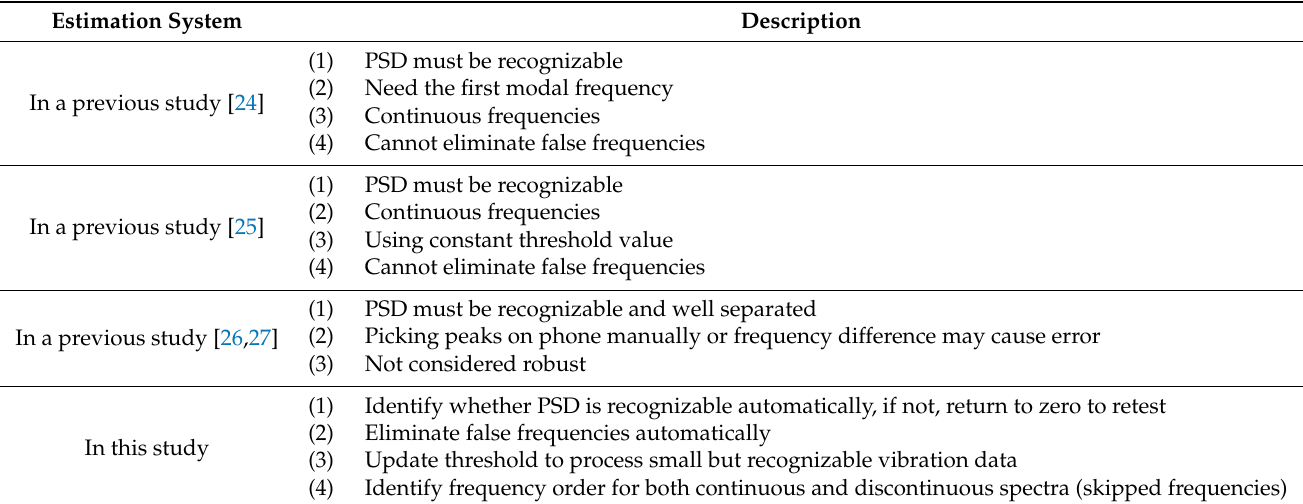
Table 4. Estimation system in this study compared with previous